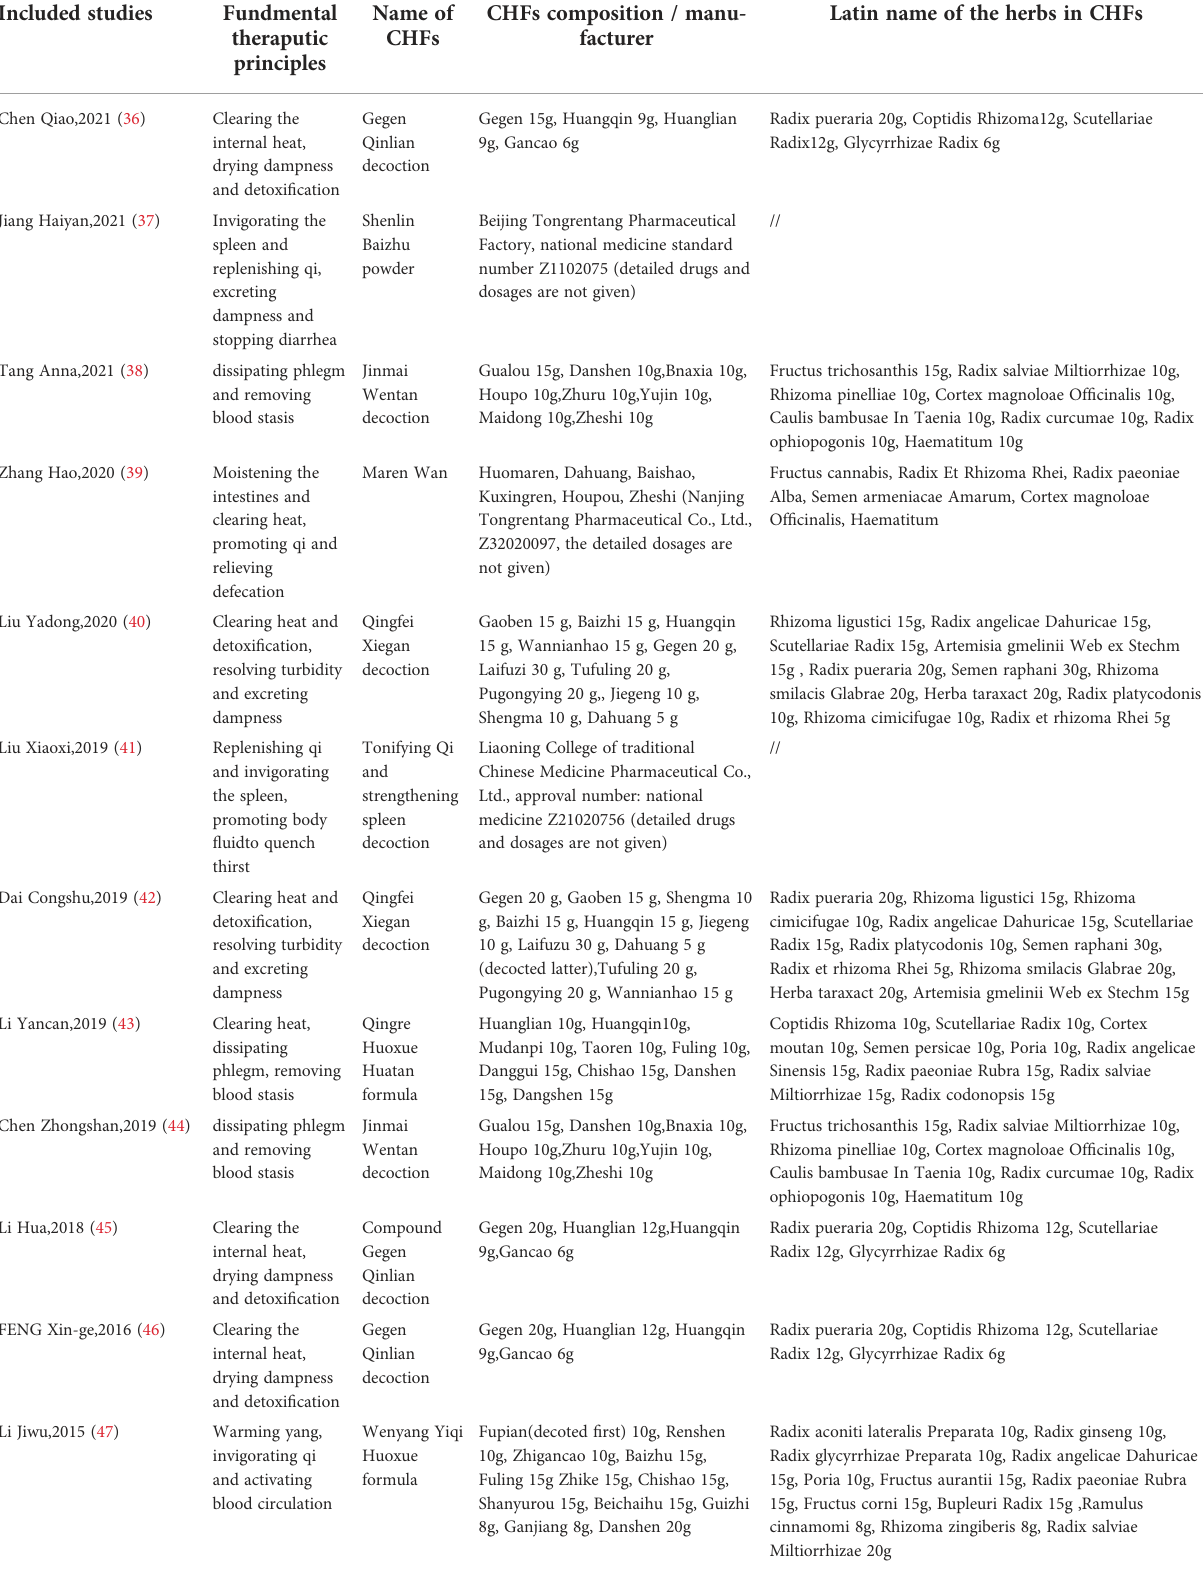
TABLE 3 The therapeutic principles and compositions of the CHFs in the experimental